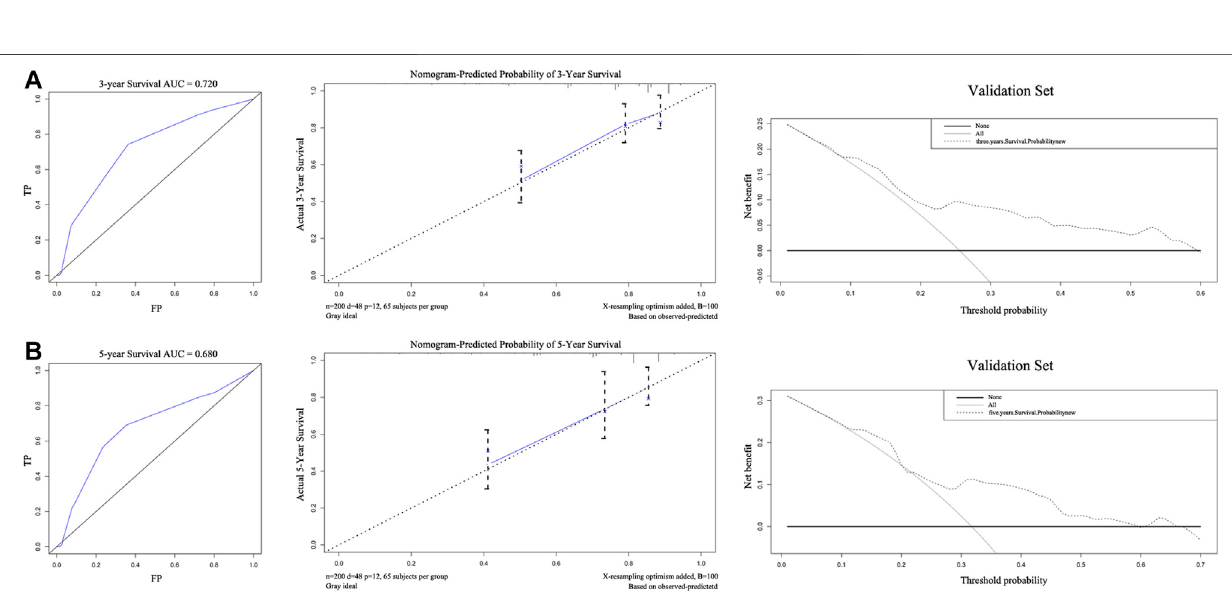
Frontiers in Genetics |